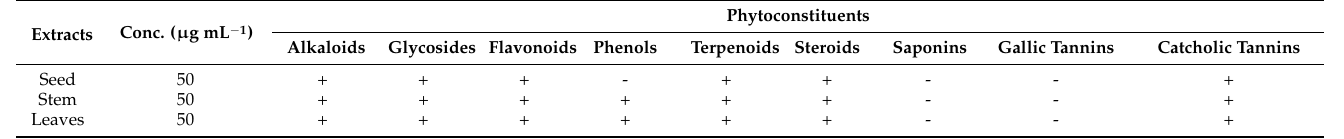
Table 2. Qualitative analysis for phytochemicals from different parts of S. marianum